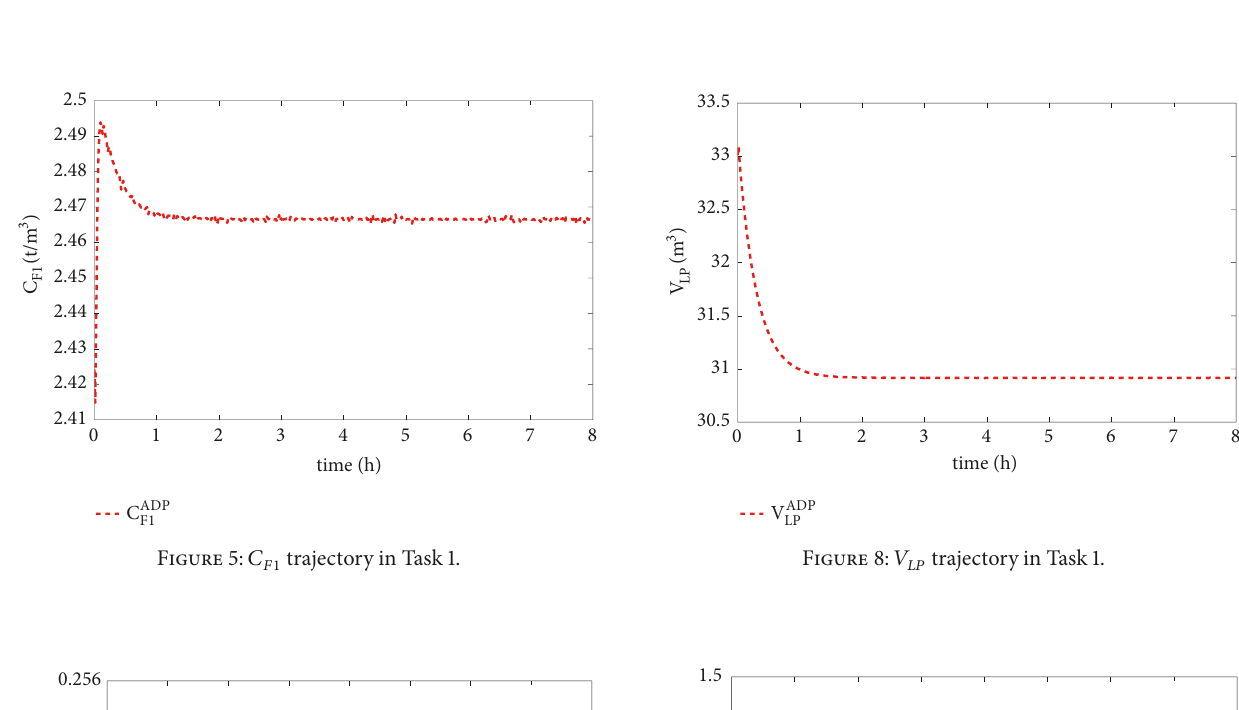
Figure 4: 𝐶 𝑃1 trajectory in Task 1.